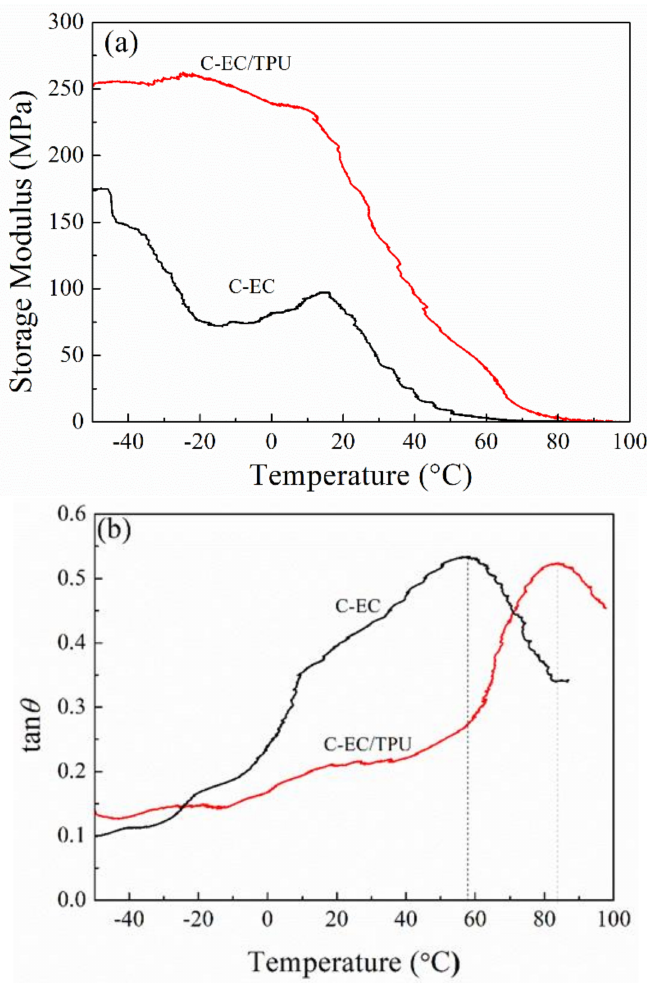
Figure 7. The relationship between ( a ) storage modulus and ( b ) loss factor (tan θ ) and temperature of C-EC and C-EC / TPU